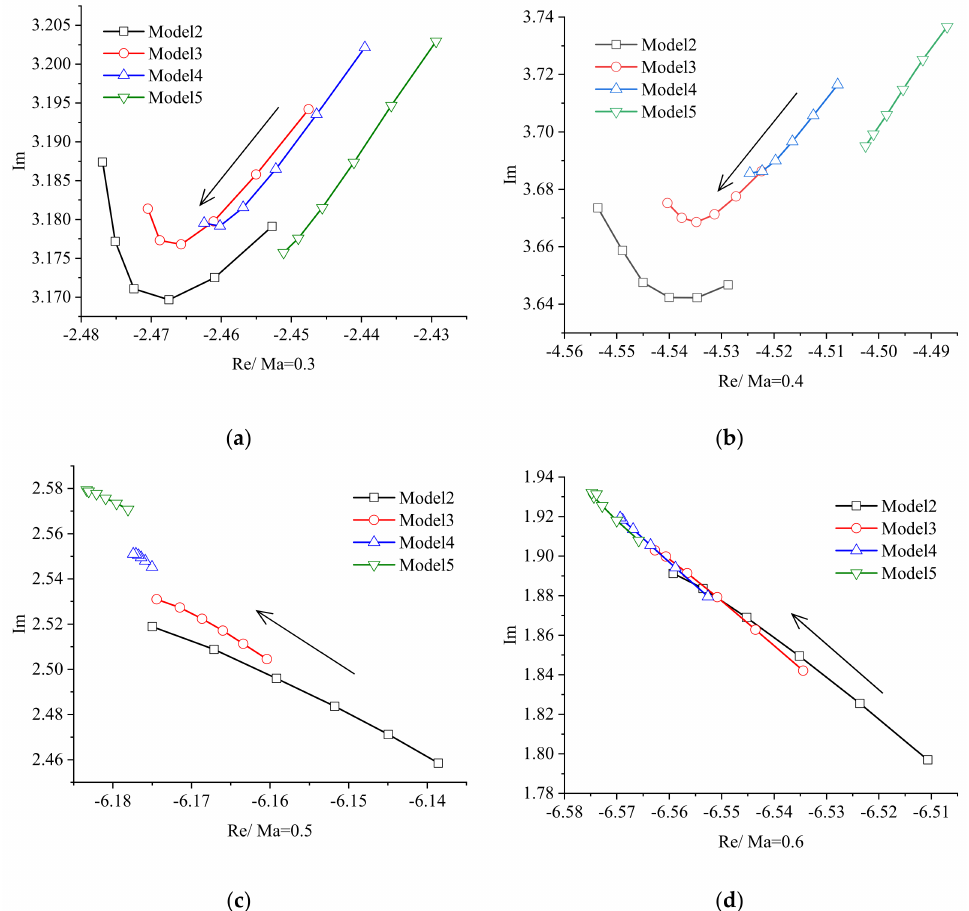
Figure 12. The changes in the short-period characteristic roots of the system with the configura- tion after stabilization augmentation under the following different Mach numbers: ( a ) Ma = 0.3, ( b ) Ma = 0.4, ( c ) Ma = 0.5, ( d ) Ma =